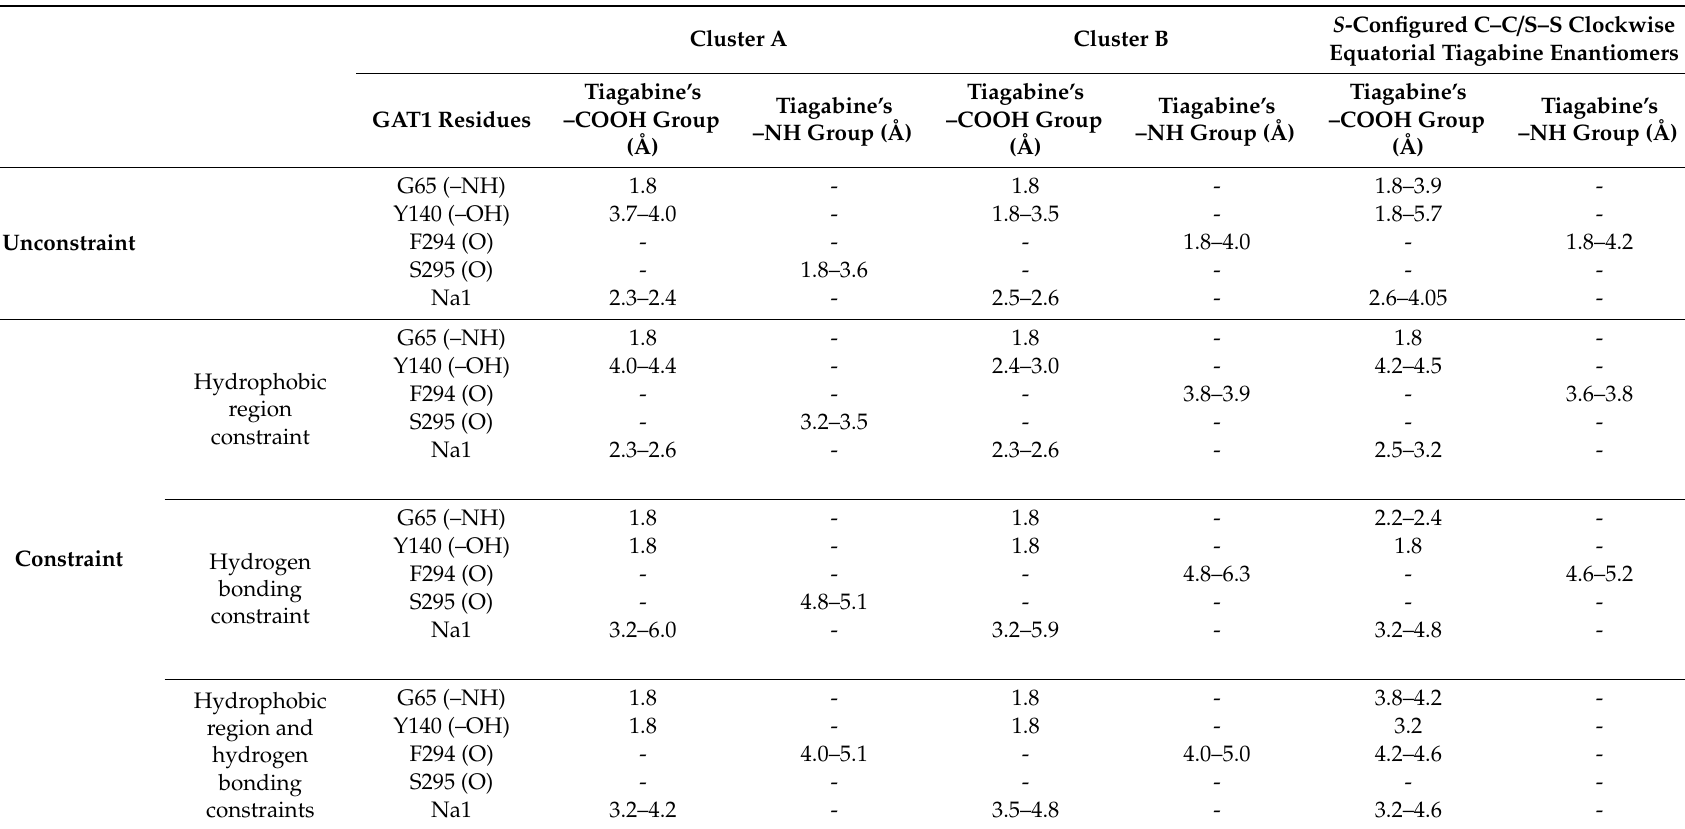
Table 3. Distances range of –COOH and –NH groups in binding solutions of R - and S -enantiomers of tiagabine in cluster A, B, and additional two entries